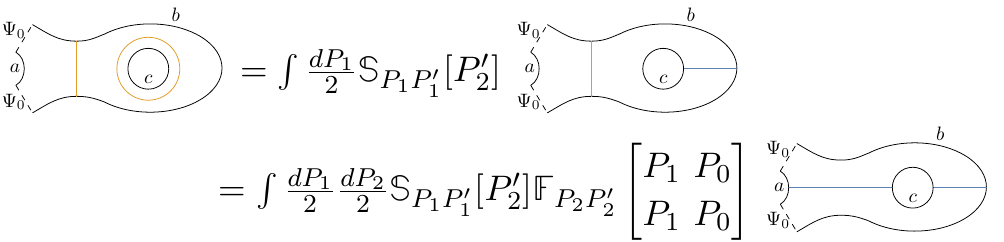
Figure 7 . The sequence of moves expressing the boundary OPE channel of the cylinder two-point block in terms of the boundary necklace channel block: a holomorphic modular kernel, followed by a holomorphic fusion